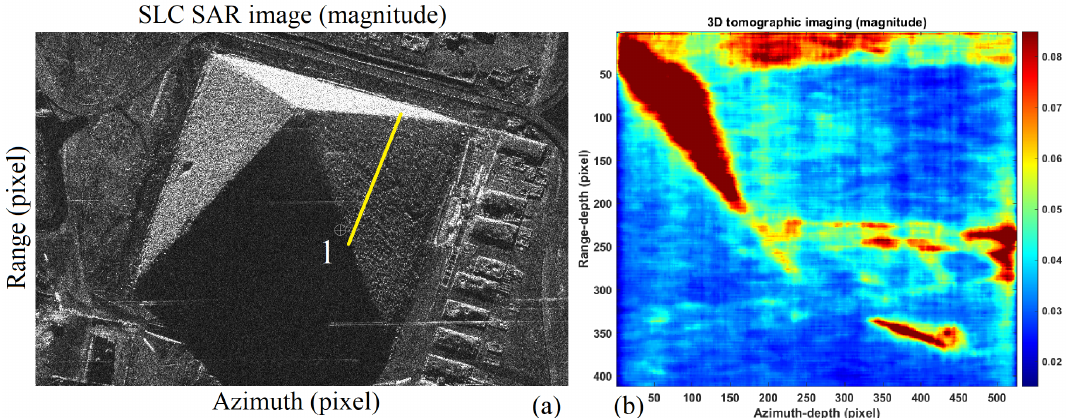
Figure 38. SAR images. ( a ): SLC SAR image (magnitude). The tomographic line 1 is oriented along the Southern-side of the pyramid. ( b ): Tomographic result (magnitude).